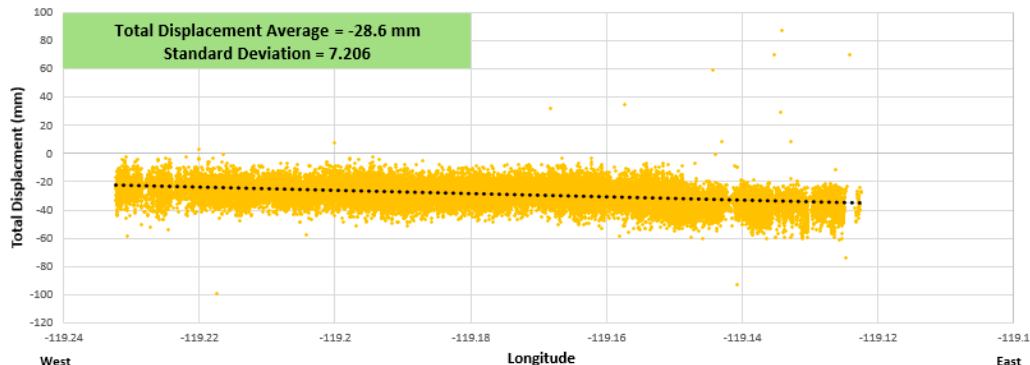
Table 1. Distinguishing between regional and site-based/structural displacement along the Santa Clara River Bridge.